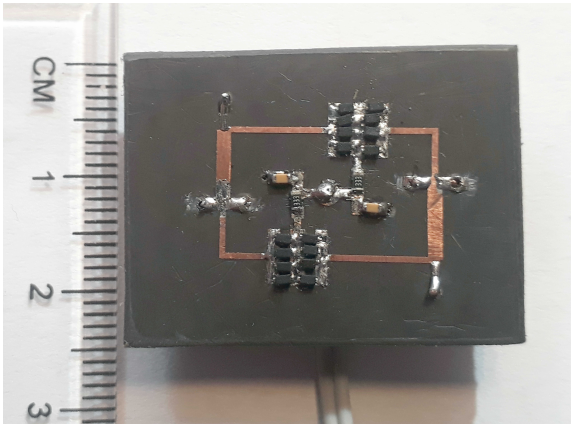
Figure 11. Photo of the fabricated prototype of the proposed tunable bandpass filter.